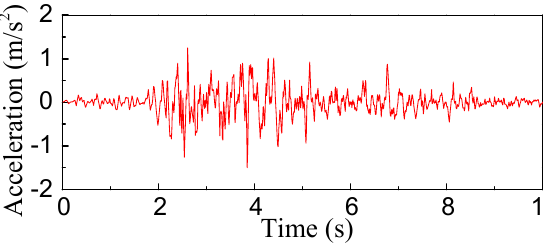
Figure 20. Input ground motion.